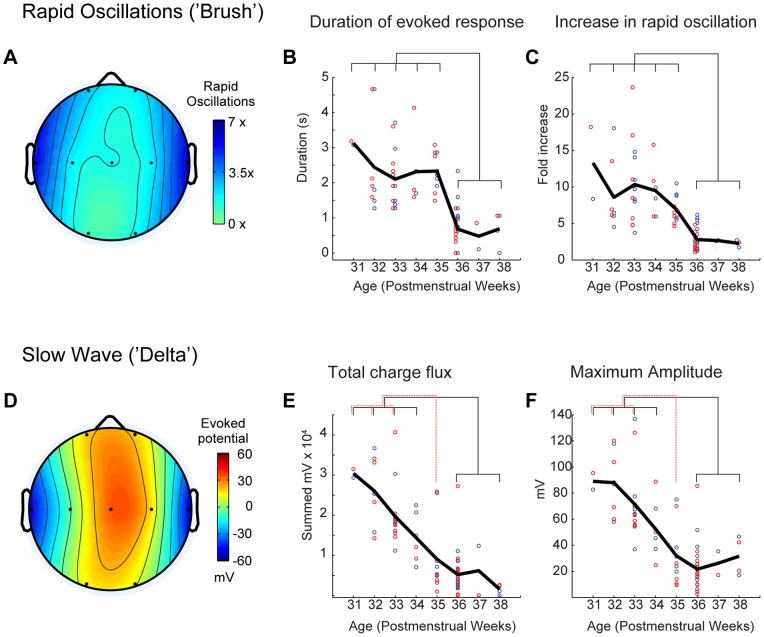
Developmental profile of auditory evoked responses.Pooled averages from all premature infants quantifying developmental changes in the rapid oscillations of the delta-brush (‘brush’) (A–C) as well as the slow negative wave (‘delta’) (D–F). A. Topography of rapid oscillations (8–25 Hz) evoked by auditory stimulation at 31–34 postmenstrual weeks (PMW) shows a temporal dominance. Frequency power is summed in the relevant frequencies 2 s after stimulation and compared to before. B. The duration of evoked rapid oscillations is shown for the T3 (red) and T4 (blue) electrode for each premature according to PMW. Thick black line shows population mean. Thin lines show significant difference between age groups (p<0.05). C. As B but peak increase in frequency power is plotted. D. Topography of the mean evoked potential at the peak of the negative potential (860 ms) after stimulus for 31–34 PMW. Blue color shows temporal prominence of negative potential. E–F. Quantification of evoked negative slow wave for T3 (red) and T4 (blue) electrodes. Thick black line shows population mean. Thin lines show significant difference between age groups (p<0.05). The summed negative potential in the 2 s following stimulation (‘Total charge flux’, E) and the peak amplitude of the negative potential (‘Maximum Amplitude’, F) are also shown.